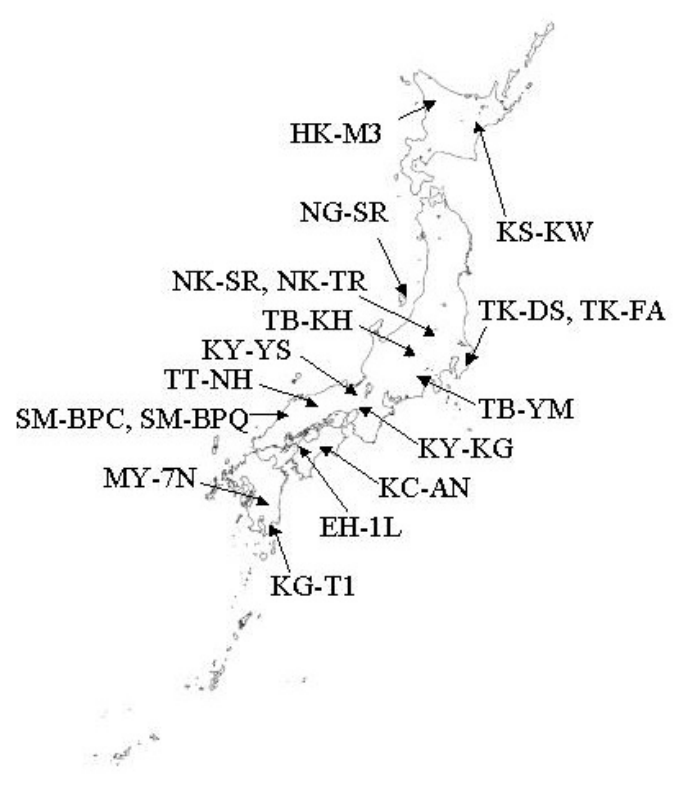
FIGURE 1 . Locations of the watershed study sites. See Table 1 for site